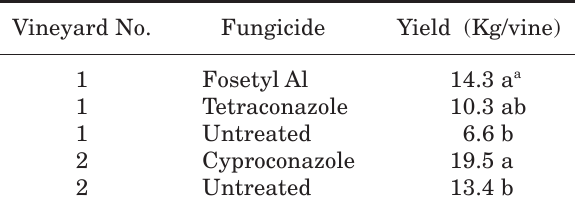
Table 6. Vines receiving trunk injection: average yield in